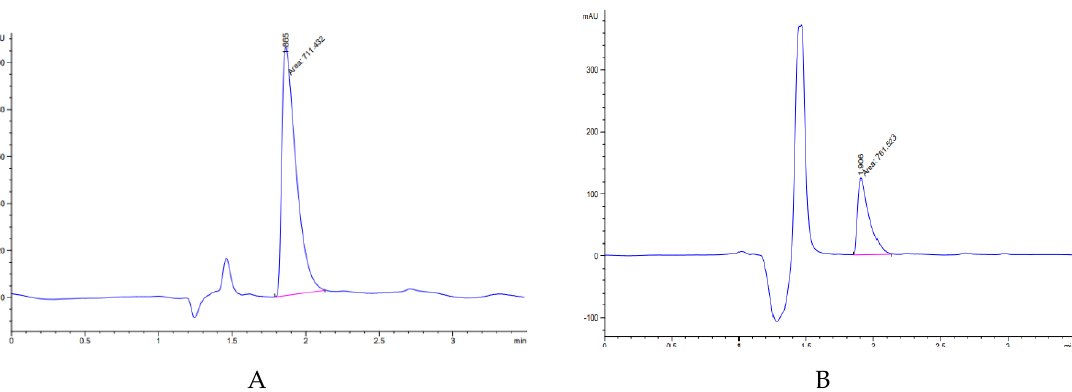
Figure 5. ( A ) Accuracy 100% chromatogram loperamide HPLC method, ( B ) 200 mg ODT chromatogram.